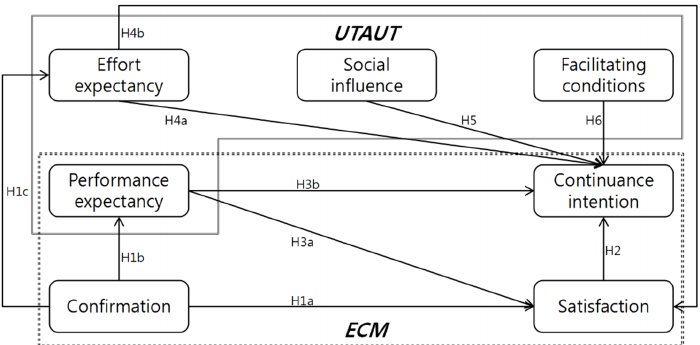
Figure 1. Research